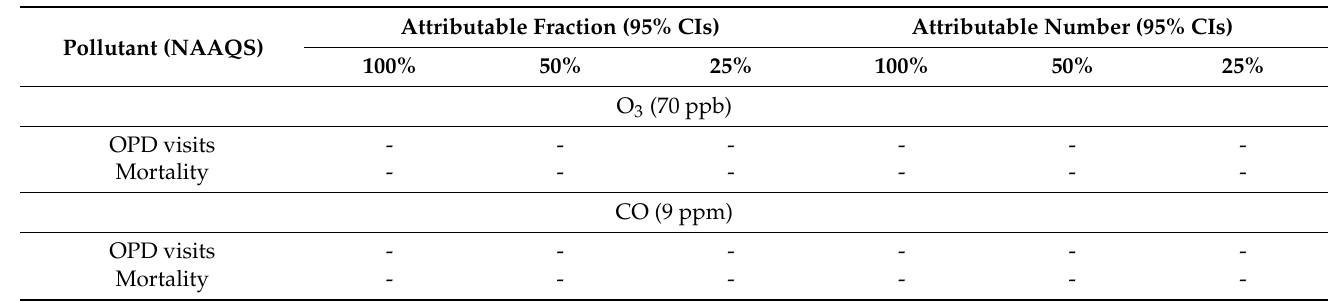
Table 8. Attributable fractions and attributable numbers of outpatient department (OPD) visits